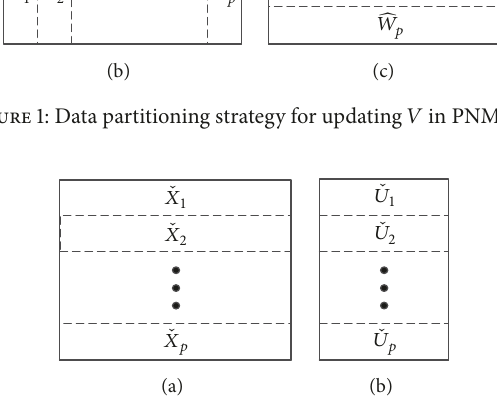
Figure 2: Data partitioning strategy for updating 𝑈 in